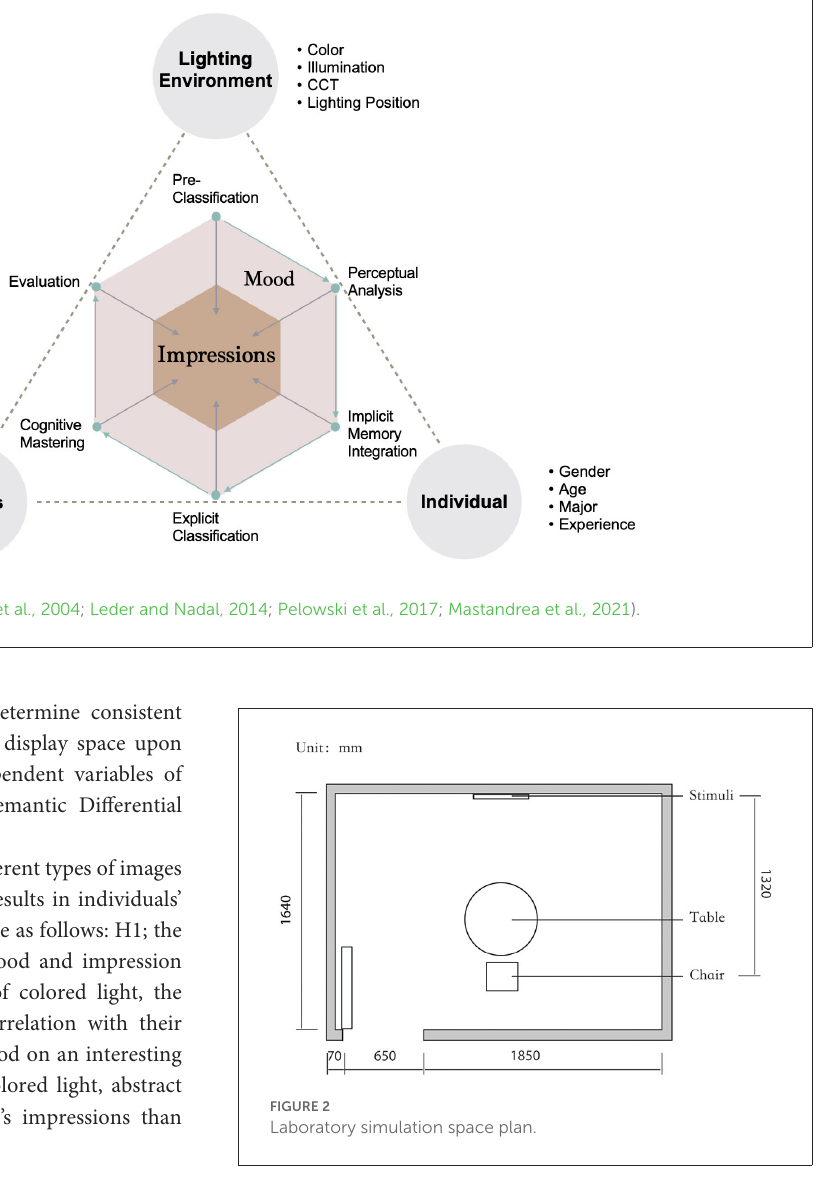
colors in the experiment: green, blue, red, and yellow. The light color calibration is shown in Table 1; the related data were measured using a Spectroradiometer JETI Specbos 1201. The light equipment used was from a Philips hue white and color ambiance starter kit A60, and the illuminance on the picture surface was controlled at 250 lx. One lighting position was above the picture on a white wall, and the other was at the center of the ceiling in order to render the entire space. The waiting area for resting and completing information forms was outside the darkroom. The lighting condition of the waiting room was 5700k and